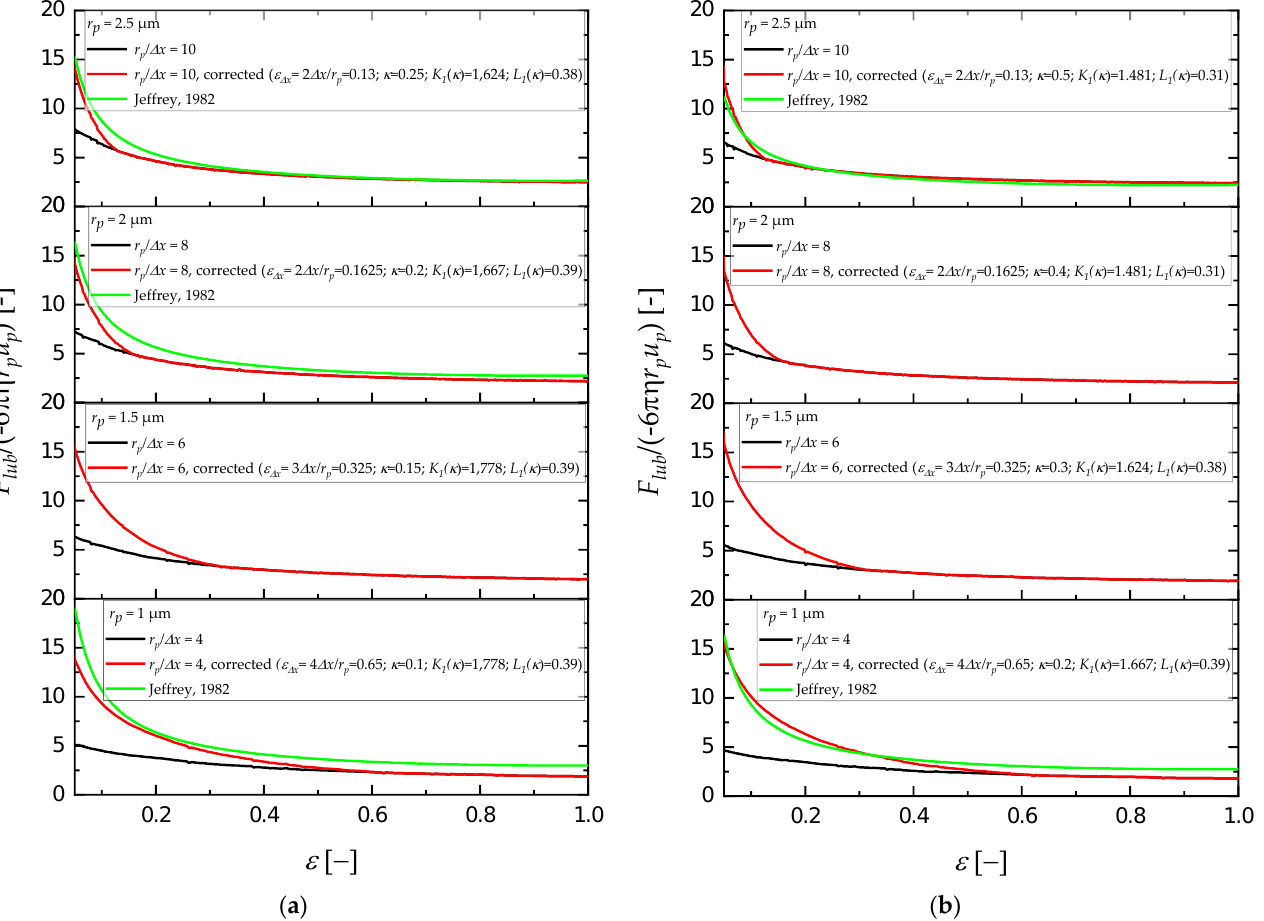
Figure 3. In these validation simulations, a single particle was moved toward a cylindrical post. The nondimensionalized force arising between particles and a post wall (i.e., the amplification factor λ ) was plotted as a function of the nondimensionalized distance, ε , from the post. The plots show, for the approach of a particle to a cylindrical post with a diameter of ( a ) 10 µ m and ( b ) 5 µ m, the results for the IBM without lubrication correction, with lubrication correction and analytical solution for λ by Jeffrey (two approaching spheres of different sizes) [52]. For the combinations for which no solution exists for K 1 ( κ ) and L 1 ( κ ) , the values for the closest radius combinations were assumed. Since no information is known about the force between a sphere and a rod with a triangular base, the values of the cylinders were adopted for those DLD